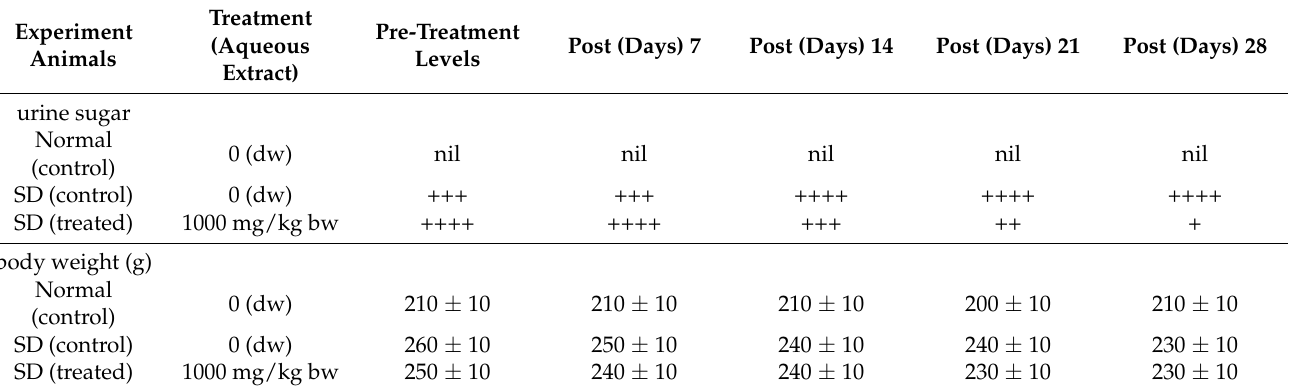
Table 7. Impact of the most effective dose of t. dioica aqueous extract on urine sugar and body weight in normal and severely diabetic (SD) rats (mean ± s.d.) for pre- and post-treatment